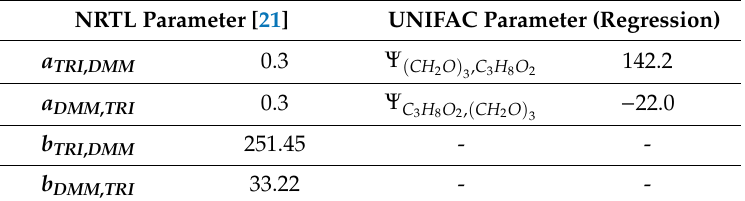
Table A1. NRTL parameters of the component system trioxane-methylal and UNIFAC interaction parameters determined by data regression.